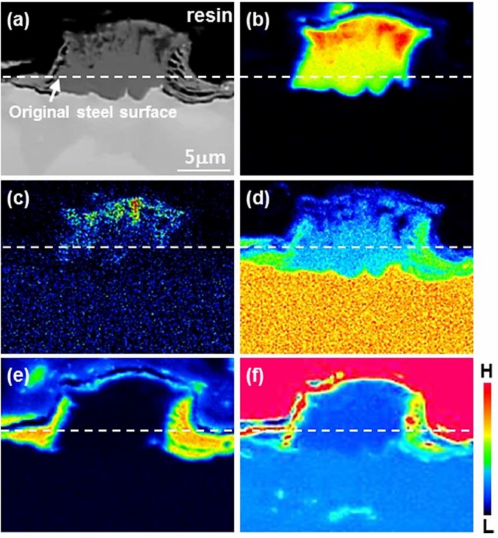
Figure 4. ( a ) BSE image; ( b – f ) Results of the EPMA area analysis of the specimen hot dipped for 10